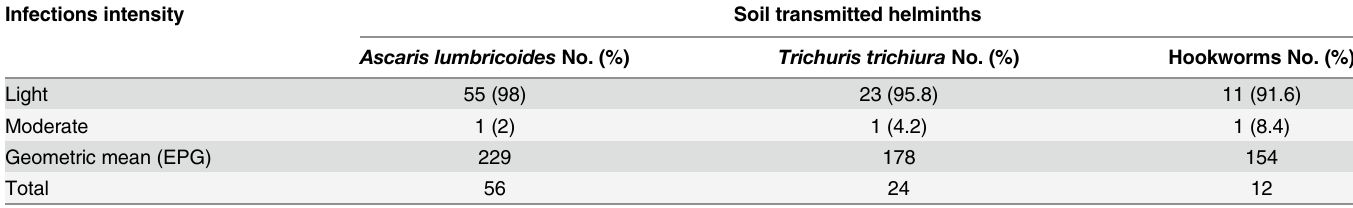
Table 2. Infection intensity of Soil-transmitted helminths among Pre-school aged children in Butajira, south-central Ethiopia, 2014. Infections intensity Soil transmitted helminths Ascaris lumbricoides No.